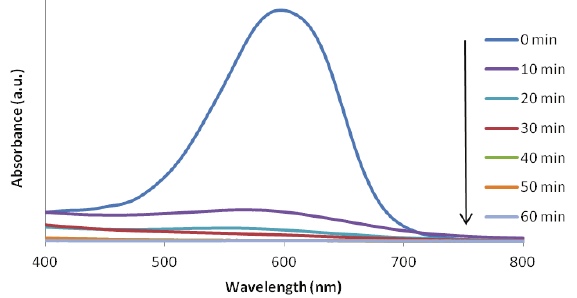
Figure 9: UV-Vis absorbance spectrum of MB at diff erent time intervals on irradiation using 0.1 g/L praseodymium tungstate as photocatalyst (Temperature of the reactor was kept constant at 25±5 °C).